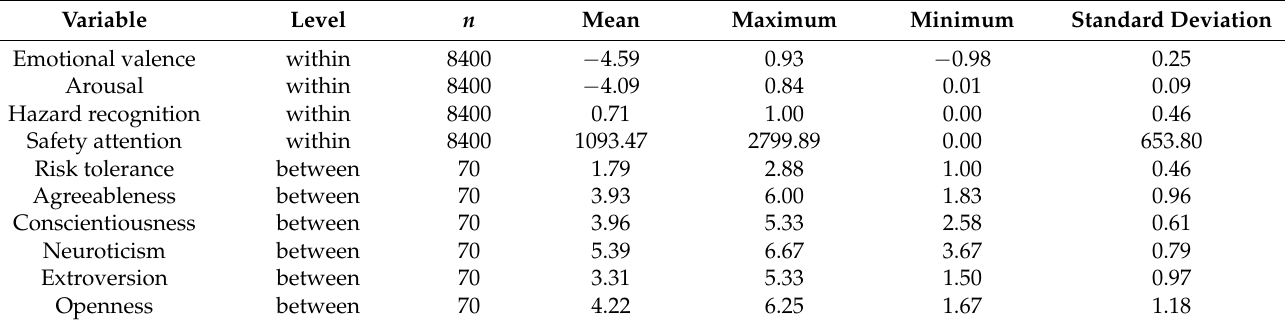
Table 2. Descriptive statistics of